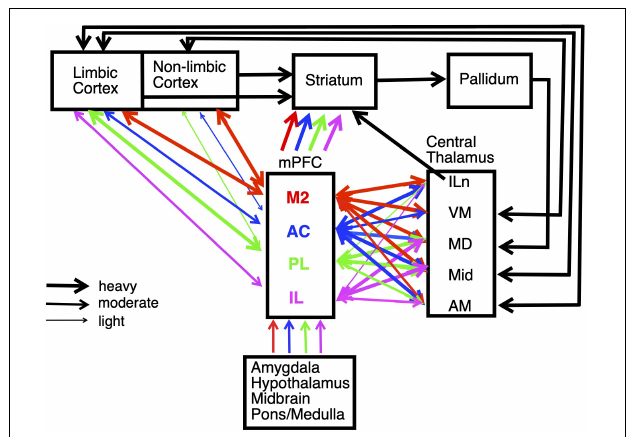
FIGURE 2 | Schematic summarizing the main connections of medial prefrontal cortex (mPFC), including interconnections with striatum and central thalamus. Pathways are color coded to identify afferent and efferent connections of the main subregions of mPFC: secondary motor (M2), anterior cingulate (AC), prelimbic (PL), and infralimbic (IL) cortices. The weight of lines indicates heavy, moderate, or light projections. Unidirectional or bidirectional transmission is indicated by arrowheads. Projections are shown for intralaminar (ILn), ventromedial (VM), mediodorsal (MD), midline (Mid), and anterior medial (AM) nuclei in central thalamus. The division of cortex into limbic and non-limbic regions follows Hoover and Vertes (2007). Estimates of mPFC projection densities rely primarily on Vertes (2002, 2004) and Hoover and Vertes (2007). See text for